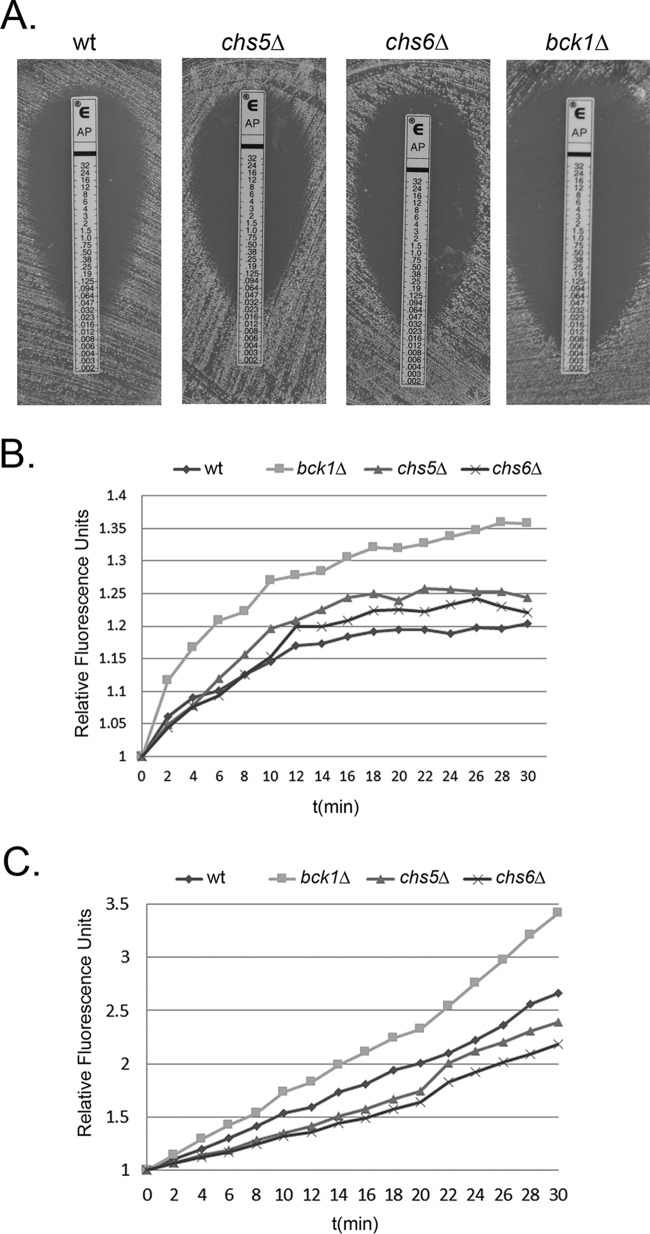
Cell integrity defects correlate with AmB sensitivity. (A) Etest analysis of AmB sensitivity in the wild type, chs5Δ mutant, chs6Δ mutant, and bck1Δ mutant. (B and C) Comparison of the rates of association of DiOC6 stain (B) and CellMask green live stain (C) between the wild type, chs5Δ mutant, chs6Δ mutant, and bck1Δ mutant strains.